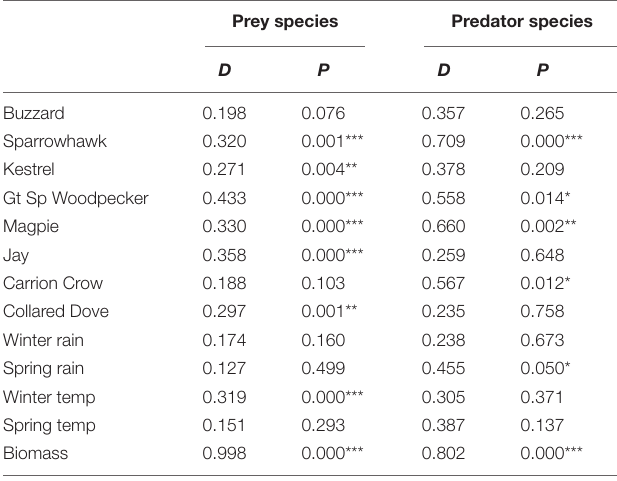
TABLE 2 | Kolmogorov–Smirnov tests of the null hypothesis that one-tailed probabilities of predator, weather and biomass effects on prey and predator species have a uniform